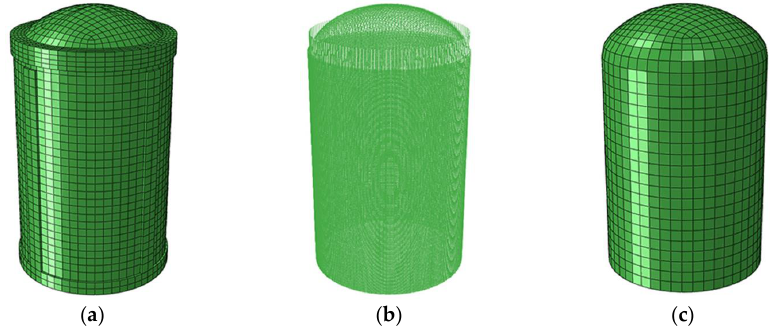
Figure 6. The FEM model. ( a ) Concrete; ( b ) Tendon and rebar; ( c ) Steel liner.